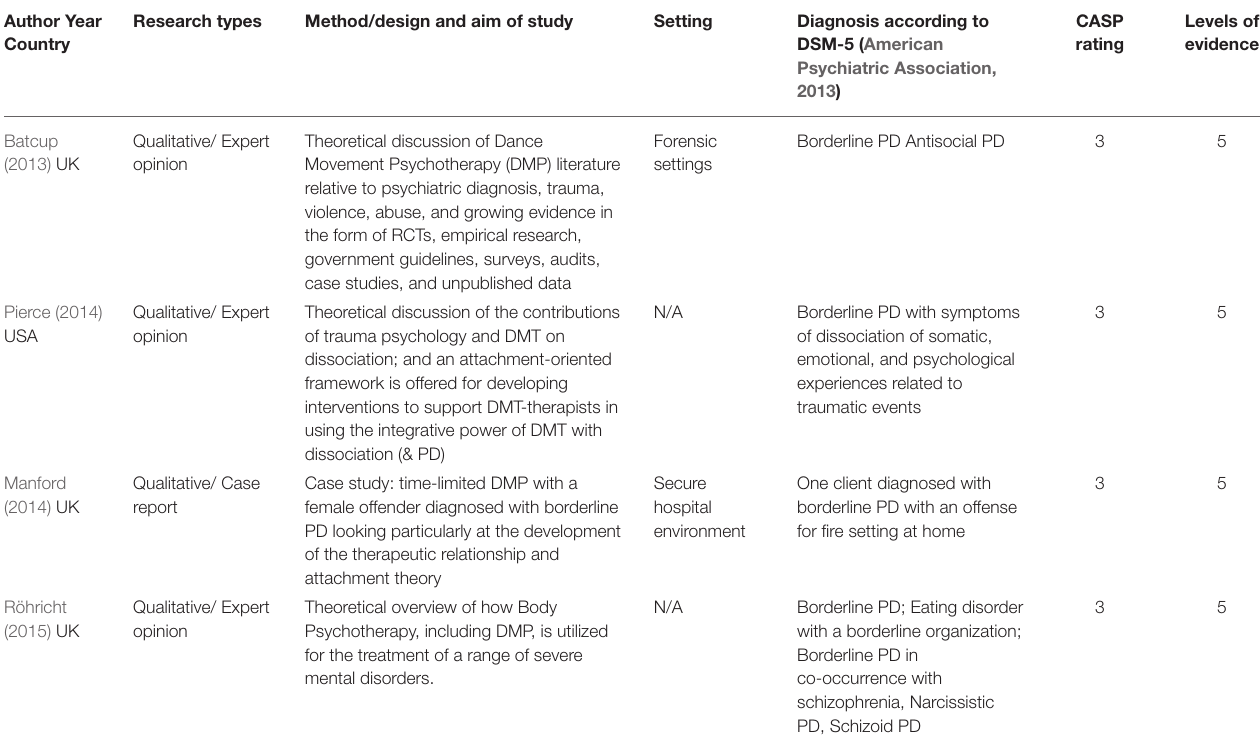
TABLE 2 | General characteristics of included articles.